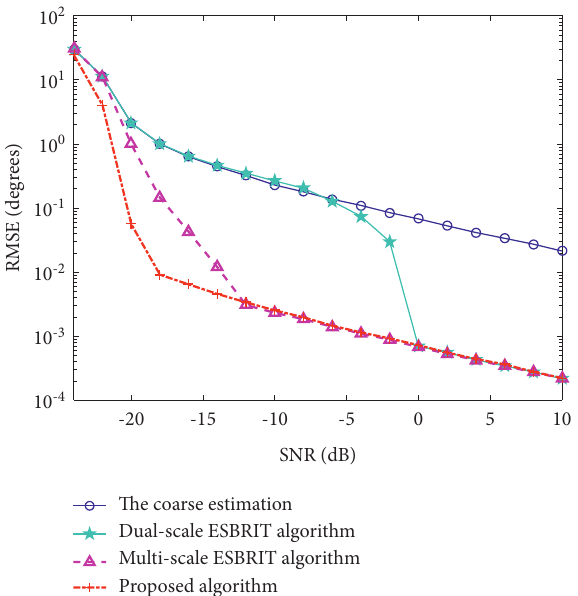
Figure 12: The comparison of the performance of the three algorithms.